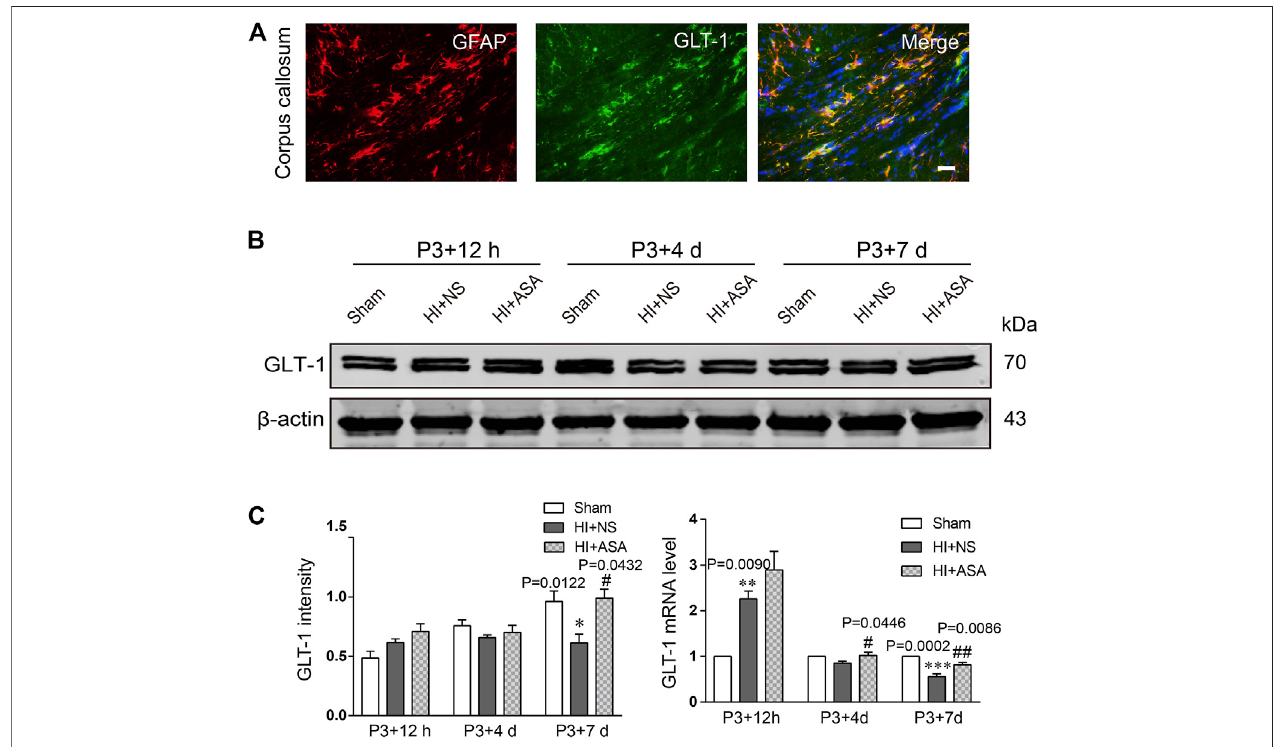
FIGURE4| α -Asaronolincreasestheexpression ofGLT-1inthePWMI ratmodel. (A) GLT-1proteinexpression wasdetected bywesternblottingat P3+12 h,P3 + 4 d, and P3 + 7 d. (B) GLT-1 was quanti fi ed and normalized against β -actin. (C) The mRNA level of GLT-1 was quanti fi ed by qPCR. All data are represented as the mean ± SEM. * p < 0.05, ** p < 0.01, *** p < 0.001 vs. sham group, # p < 0.05, ## p < 0.01 vs. HI + NS group. N = 4 for each